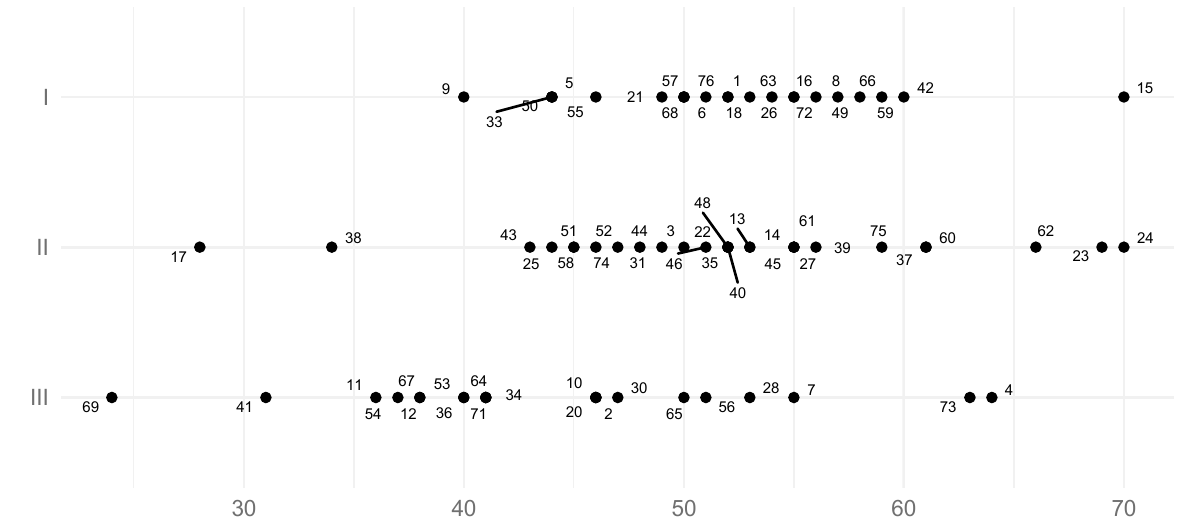
Figure 5. The distribution of the right sagittal condylar inclination (SCI) coefficient value. Numbers represent patients’ IDs.